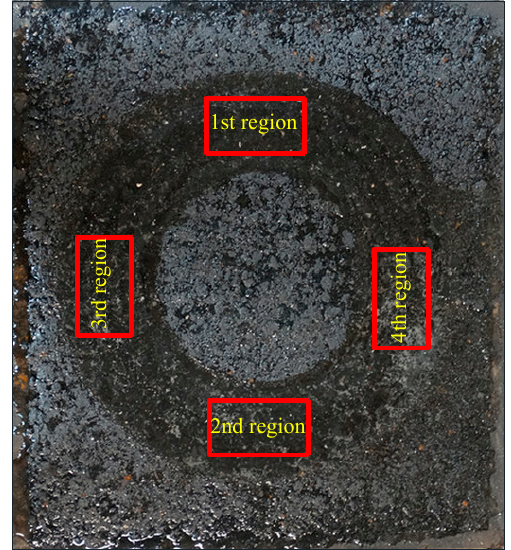
Figure 4. The schematic diagram of 3D texture test area.